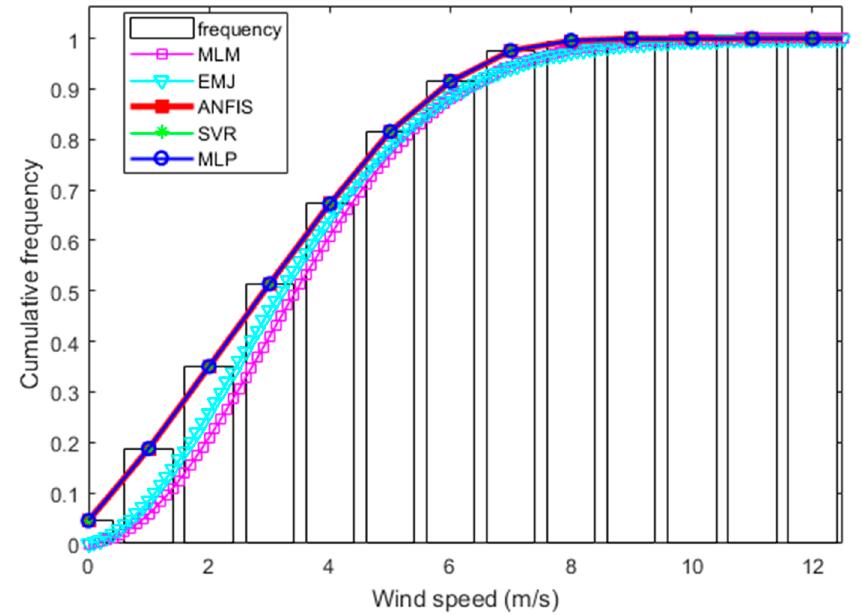
Figure 11. Fitting the cumulative wind speed frequency for the site of Lomé.